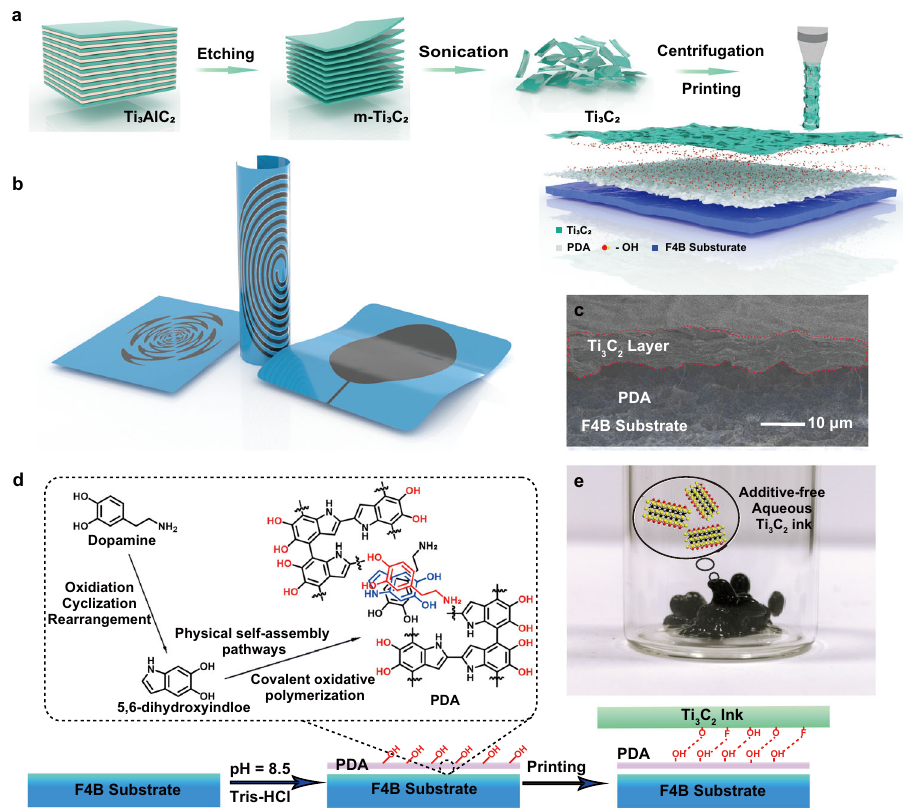
Fig. 1 | Preparation of Ti 3 C 2 for antenna. a The schematic pathways for ultrathin Ti 3 C 2 nanosheets and the direct extrusion printing of Ti 3 C 2 inks for fl exible antennas. b Differentpatternsof fl exibleTi 3 C 2 antennas. c Thecross-sectionalSEM